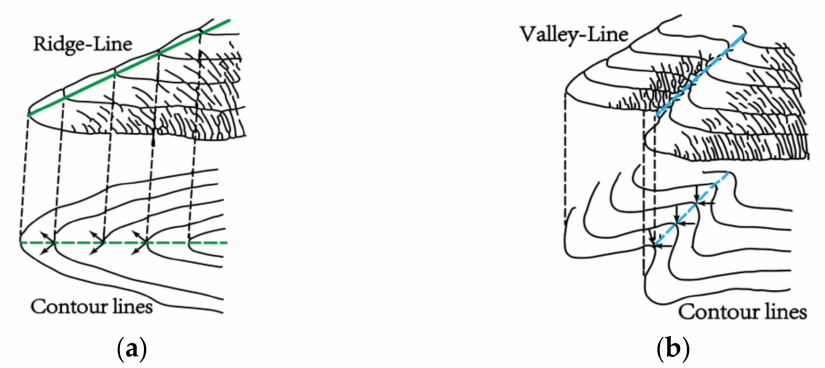
Figure 6. Schematic diagram of the terrain feature lines: ( a ) ridge line; ( b ) valley